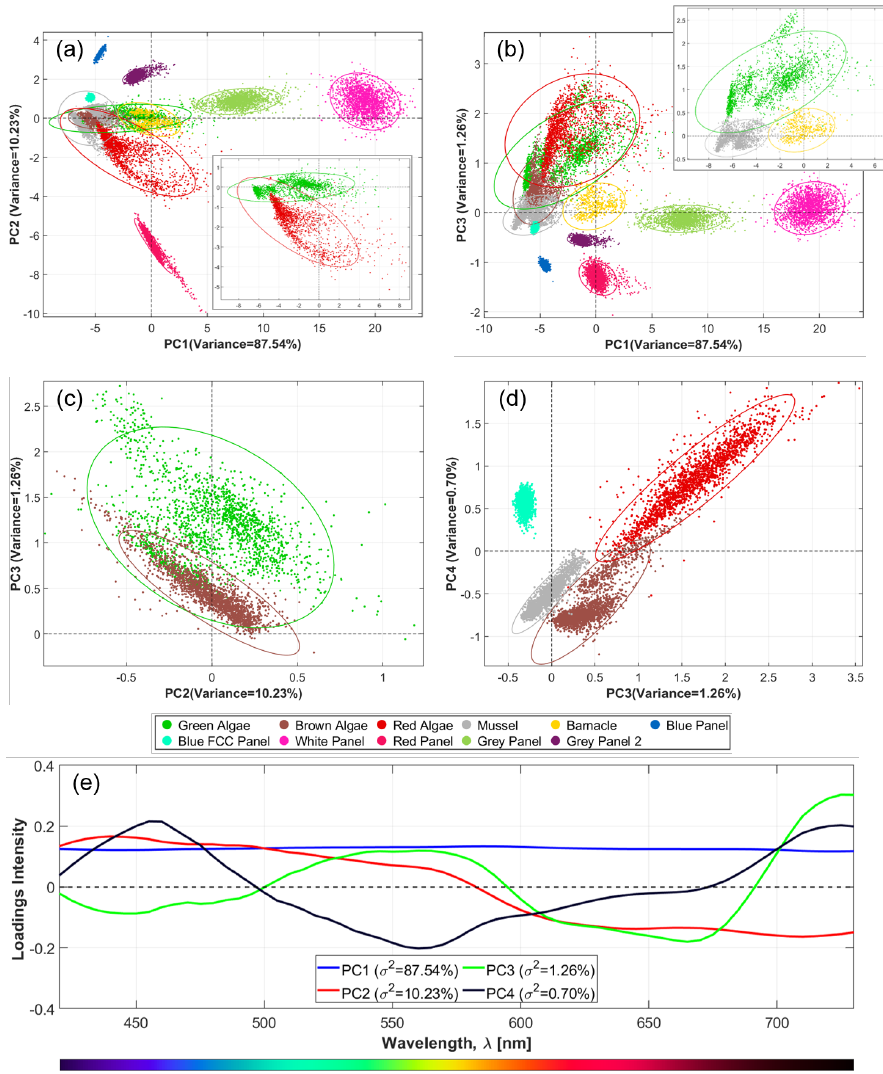
Figure 9. Principal component analysis biplots ( a – d ) and loadings ( e ) of the first four principal components (PCs). The displayed biplots are, in order: ( a ) PC1 vs. PC2, ( b ) PC1 vs. PC3, ( c ) PC2 vs. PC3, and ( d ) PC3 vs. PC4. The ellipses represent the class-specific 95% confidence interval, with the longest axis along the direction with the largest variance within each group